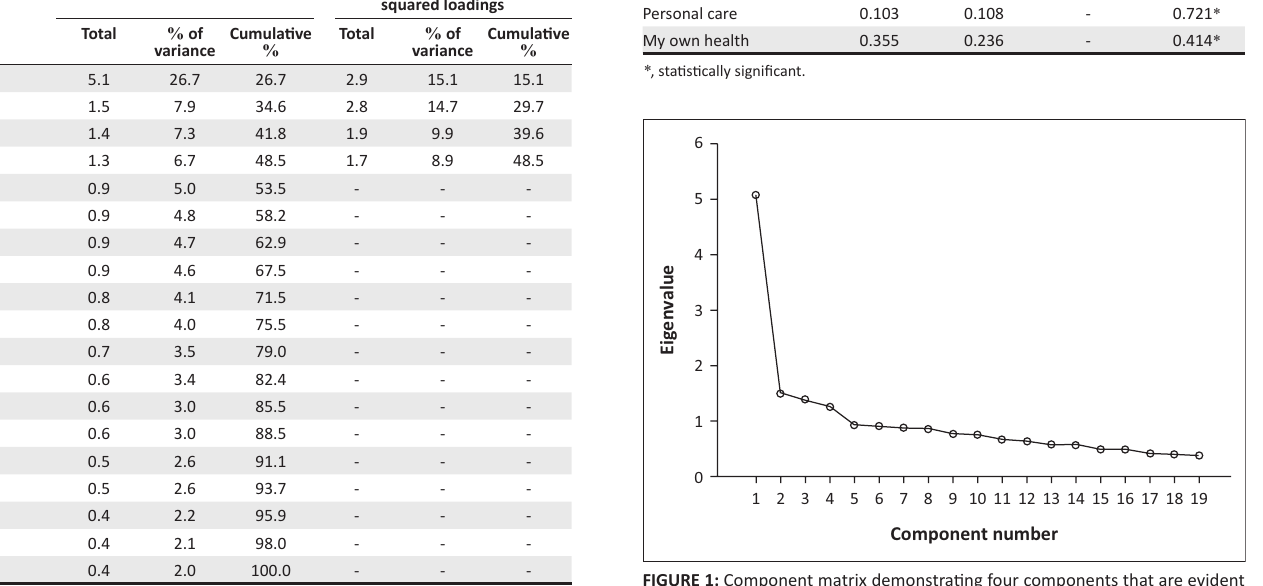
TABLE 3: Principal component analysis extraction with total variance explained, with initial eigenvalues and after rotation. PMP item